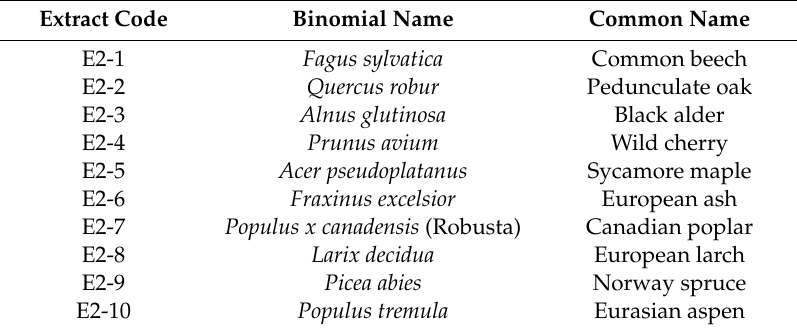
Table 1. Names of tree species and associated code of bark